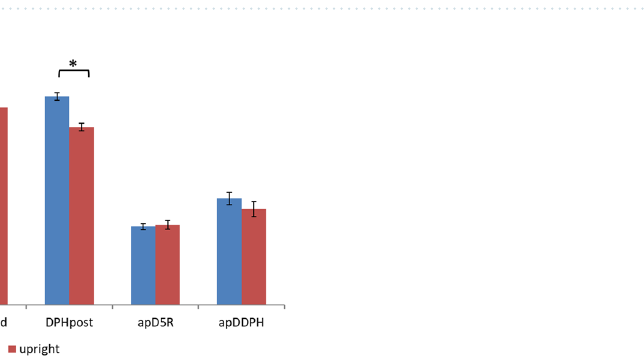
Figure 5. Elliptic curve shape with two different motion patterns in supine phonation (right diagram) is less pronounced in upright phonation (left diagram). Upright rMRI data is displayed on the left, supine hMRI data on the right. Mean normalized curve amplitude (A norm ) and standard error is displayed on the y-axis and normalized time (t norm ) is displayed on the x-axis. Different locations are displayed in different colours.